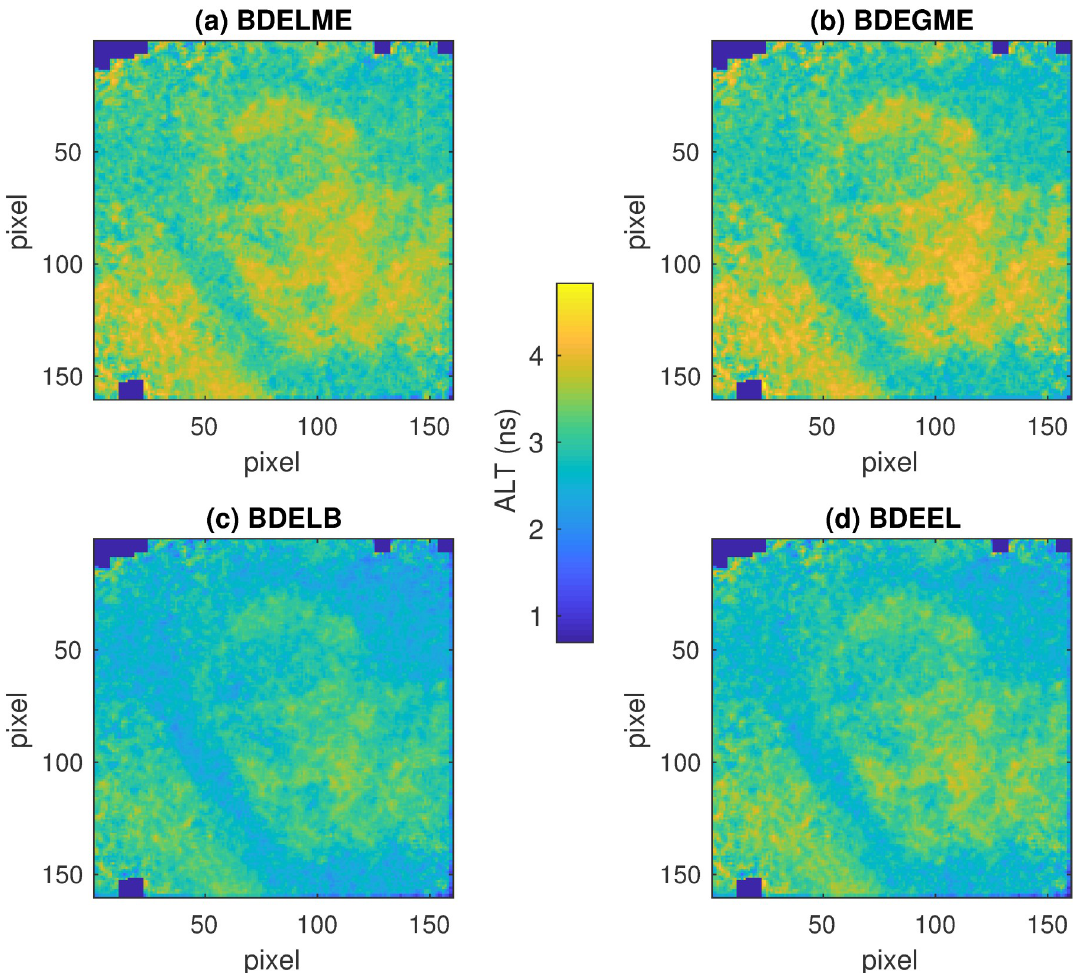
Fig 12. Average lifetime maps for lesion sample No. 82 in 3rd spectral channel: (a) BDELME, (b) BDEGME, (c) BDELB, and (d) BDEEL.